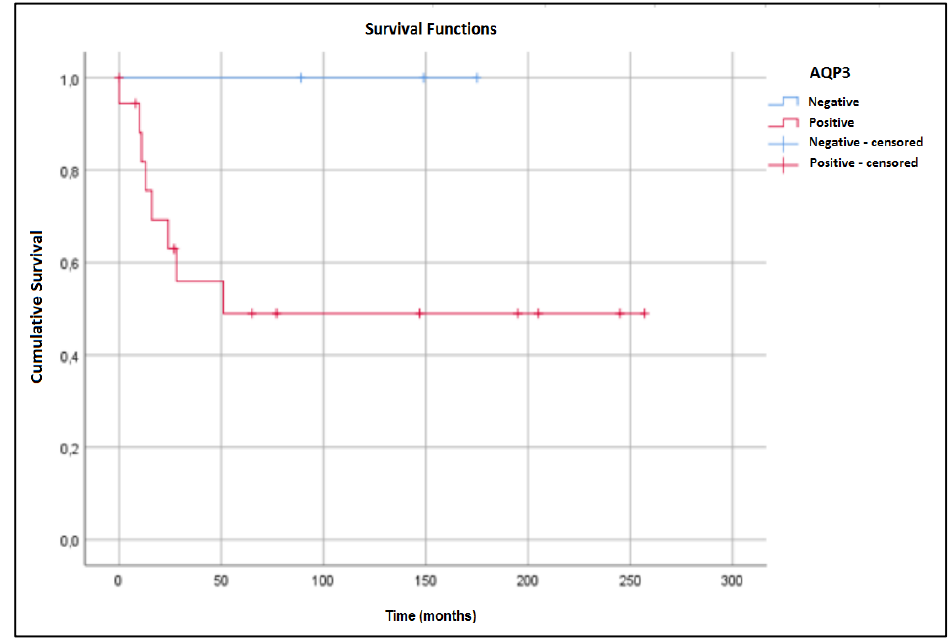
Figure 4. Overall survival curves of MEC patients. Five-year survival rates were 100.0% for patients without AQP3 expression and 49.0% for patients with expression ( p = 0.153).